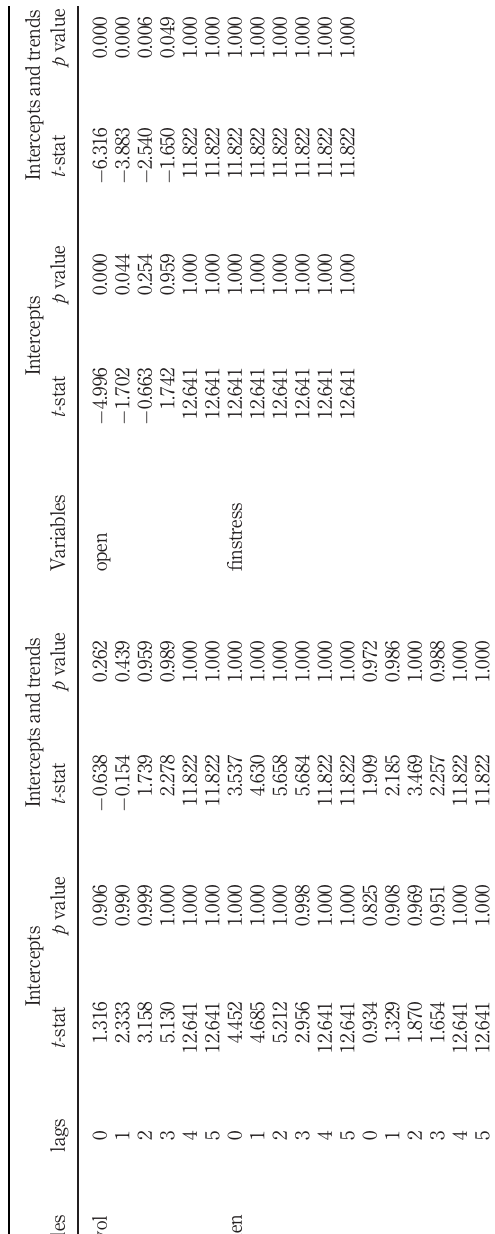
Table 2. Pesaran CADF test